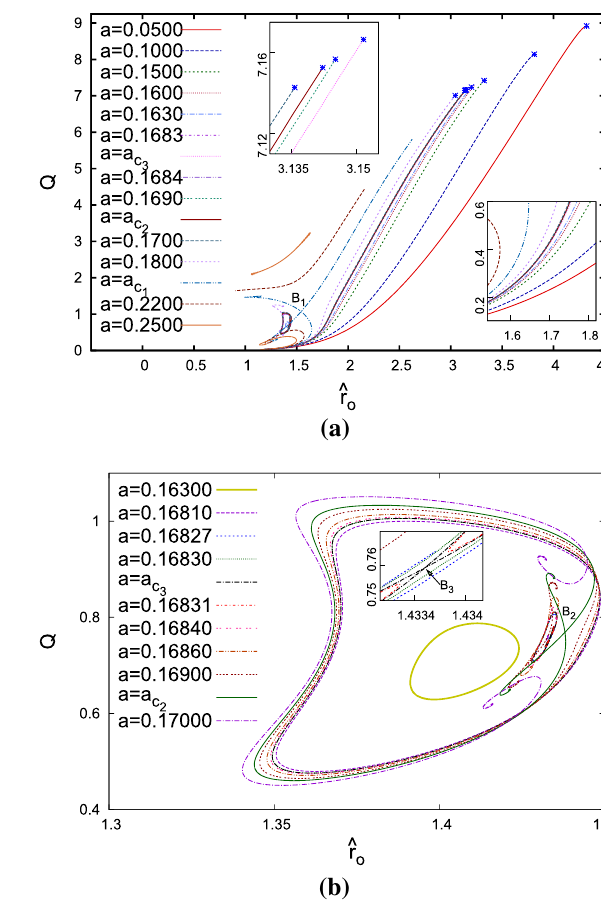
Fig. 5 a The mass M versus the radius of the star ˆ r o for a set of values of a in the range a = 0 . 0 to a = 0 . 2500. The asterisks represent the transition points from the boson stars to boson shells, and the insets magnify parts of the diagram. b Zooms into the region of the bifurca- tions, with the inset giving a magnified view of the bifurcation B3